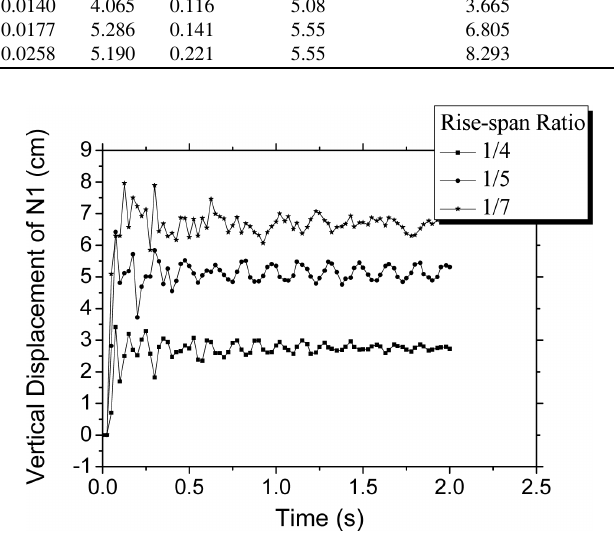
Fig. 8. Vertical displacement-time curve of N1 for different rise-span